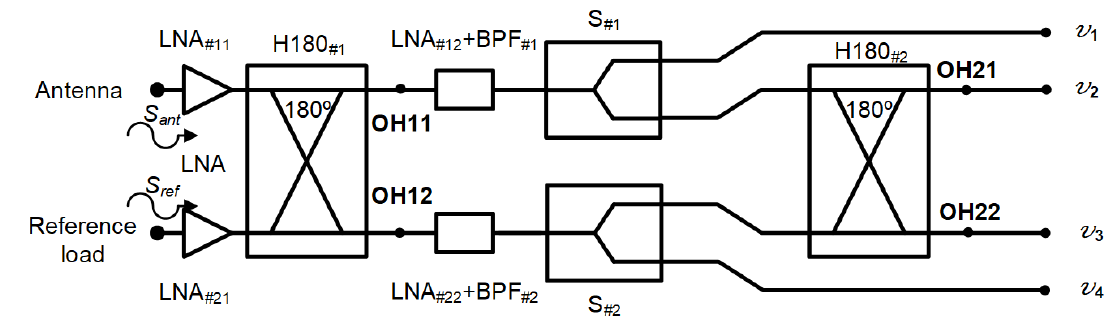
Figure 3. Simplified schematic of the proposed receiver to perform its analysis. The output signal of each subsystem in the receiver is obtained using the transfer function of each one that is defined and listed in Table 2. The low-noise amplifiers are considered to show a voltage gain g i > 1, whereas the passive subsystems have a voltage loss a i < 1, and n i the noise added by each